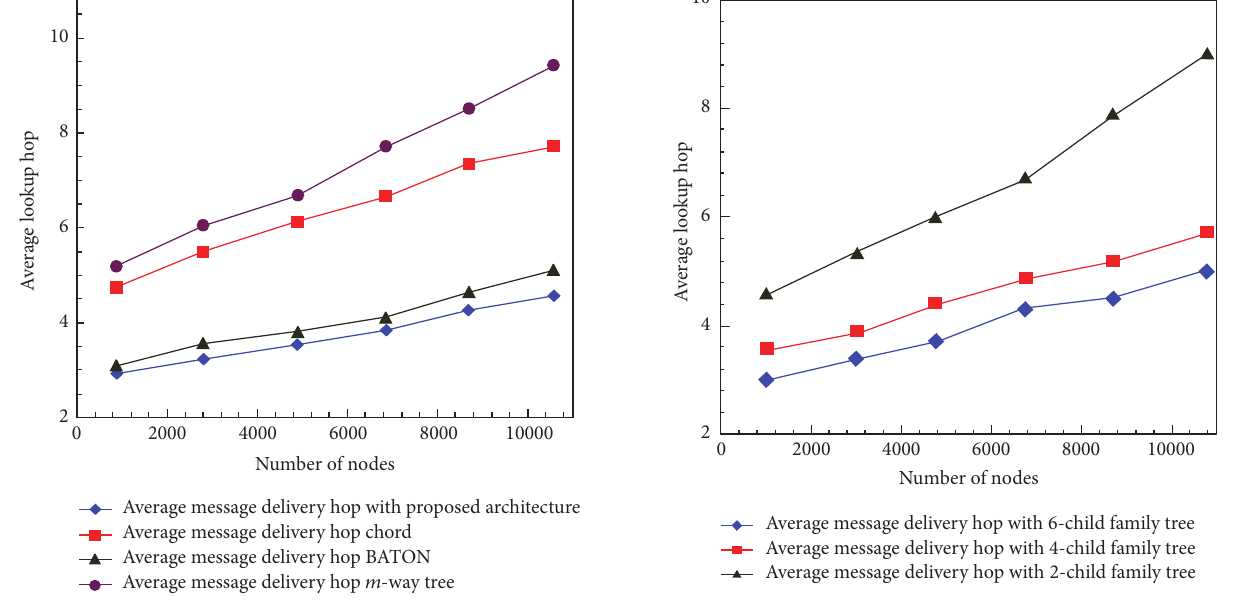
Figure 3: Comparison of different overlay network architectures with varying population.